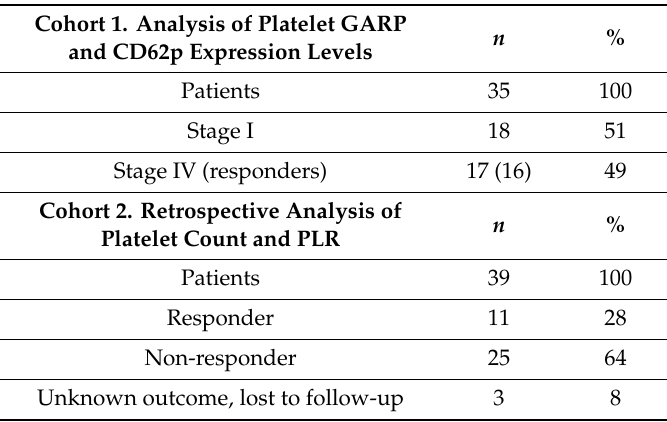
Table 1. Patient